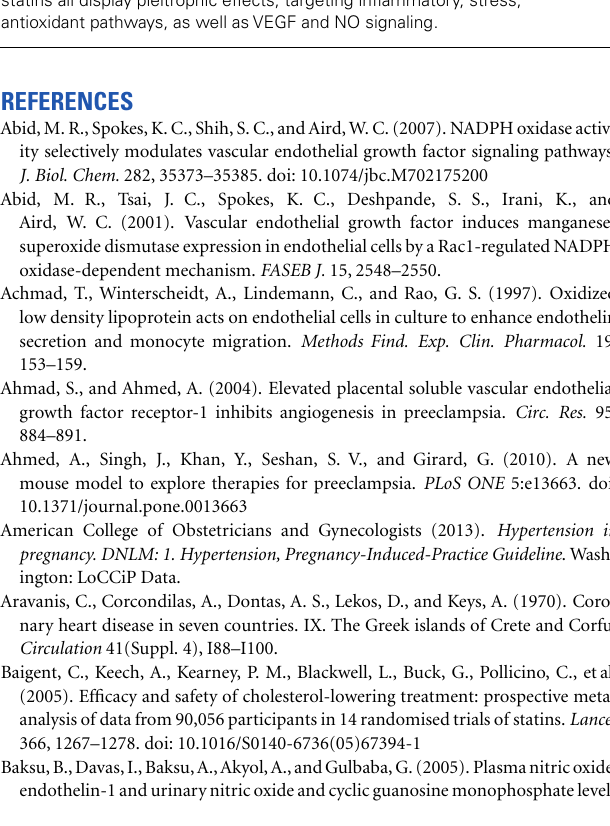
FIGURE 1 | Proposed pathways contributing to the maternal syndrome of preeclampsia and the mechanism of action of antioxidants, ER chaperones, NO, and H 2 S donors and statins. Deficient conversion of spiral arteries leads to fluctuations in O 2 concentration and triggers ischemia-reperfusion type injury of the placenta and consequent oxidative stress and ER stress. ROS activate various stress pathways, including